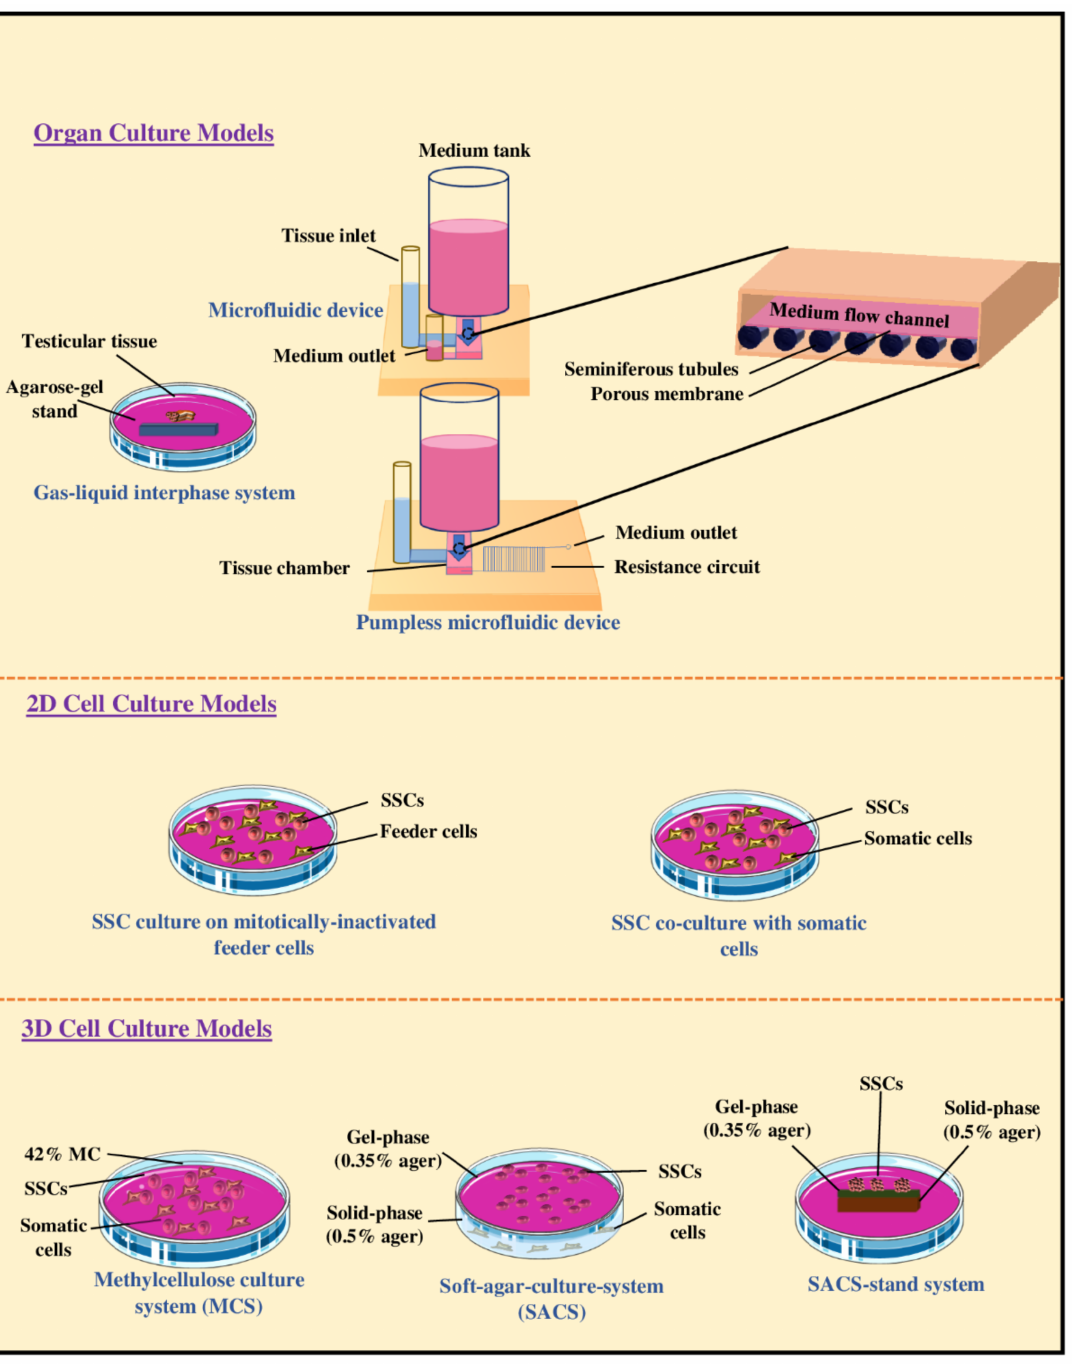
Figure 2. Schematic representation of organotypic culture of testicular tissue fragments, two-dimensional (2D), or three-dimensional (3D) cell suspension culture models for in vitro spermatogenesis. Three approaches to organotypic culture of testicular tissue fragments have been proven e ff ective including using a gas-liquid interface system, a conventional microfluidic system, or a pumpless microfluidic device. 2D culture of cell suspensions can be achieved through two approaches, namely culturing isolated SSCs on mitotically-inactivated feeder cells (e.g., mouse embryonic fibroblast cells) or culturing on mixed populations of testicular cells (co-culturing of germ cells and somatic cells). 3D cell cultures can include using methylcellulose (MCS), a soft-agar culture system (SACS), or a SACS-stand